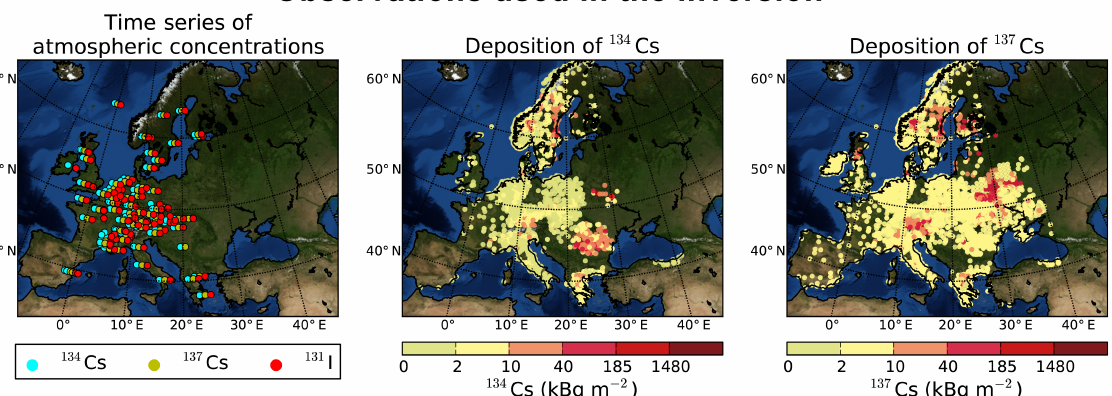
Figure 3. Locations of atmospheric activity concentration measurements of 134 Cs, 137 Cs and 131 I and deposition locations and levels of 134 Cs and 137 Cs over Europe adopted from Evangeliou et al.